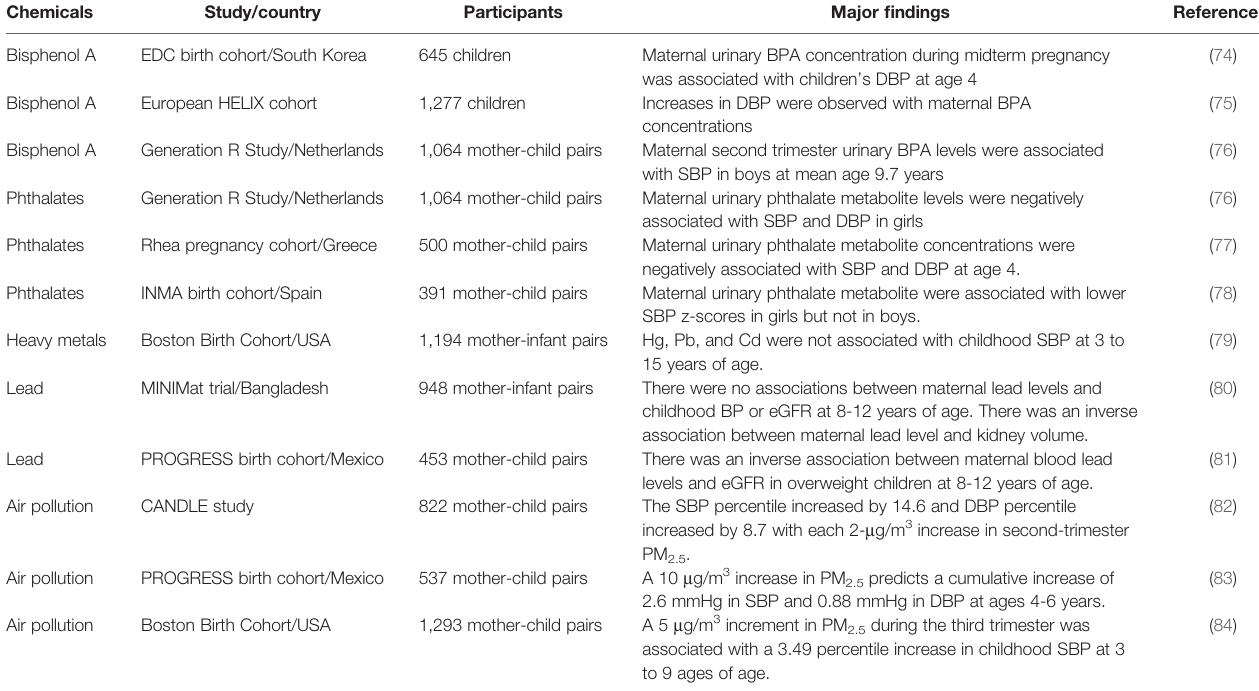
TABLE 2 | Effects of maternal environmental chemical exposure on blood pressure and renal outcomes in